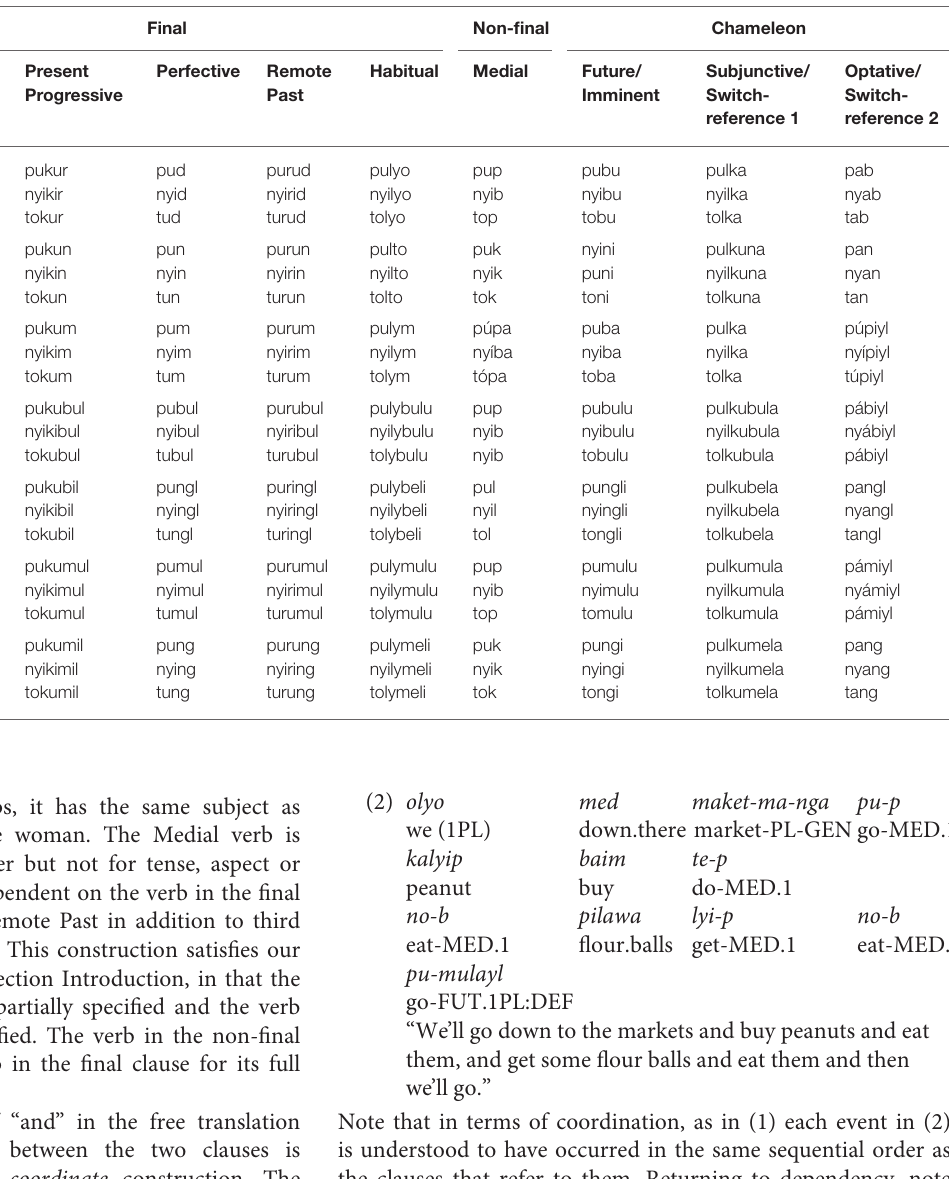
TABLE 1 | Some representative Ku Waru verb